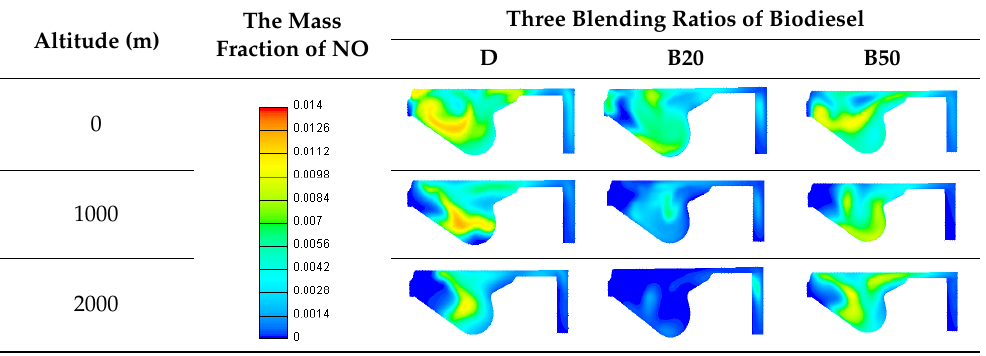
Table 5. Effect of different plateau environments on NO distribution field of cylinder with three blending ratios. Altitude (m) The Mass Fraction of NO